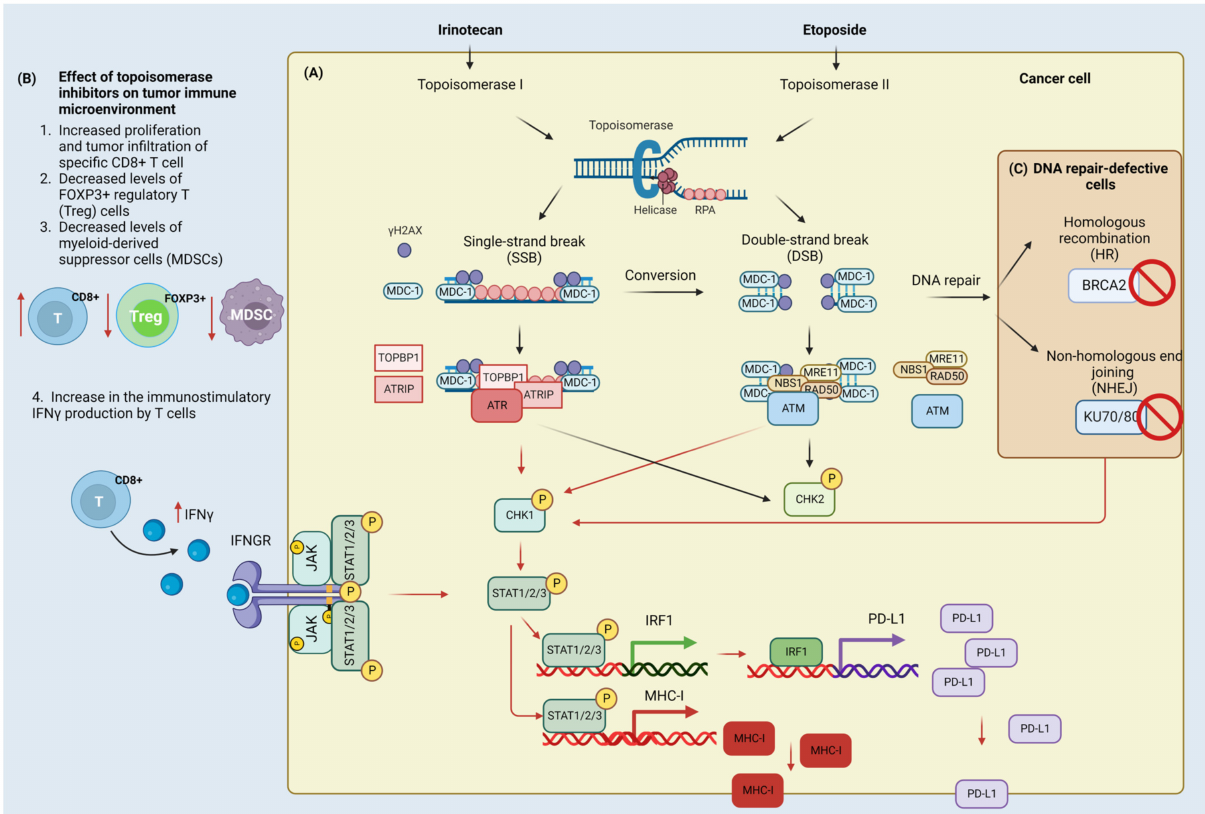
Figure 2. Effect of irinotecan and etoposide on the DNA damage (DDR) and immune response. Cancer cell ( A ) Irinotecan inhibits DNA topoisomerase I which leads to the formation of single-strand breaks (SSBs) and double-strand breaks (DSBs). Single-stranded DNA (ssDNA) in the replication fork that arises due to helicase activity is coated with replication protein A (RPA) protein and a mediator of DNA damage checkpoint protein 1 (MDC-1). MDC-1 serves as a platform protein for topoisomerase 2-binding protein 1 (TOPBP1), ATR-interacting protein (ATRIP), and serine/threonine-protein kinase (ATR). In contrast, DSBs that arise through the conversion of SSBs and activity of topoisomerase II inhibitors (here etoposide) are detected by the MRN complex composed of double-strand break repair protein MRE11 (MRE11), nibrin (NBS1), and DNA repair protein (RAD50). The MRN complex is involved in the recruitment and activation of ATM kinase. Activated ATR and ATM phosphorylate have multiple targets including checkpoint kinases (CHK1/2). The phosphorylation of H2AX and accumulation of MDC-1 contribute to further recruitment of ATR/ATM kinases and amplification of damage signaling. CHK1 activation leads to the phosphorylation of signal transducers and activator of transcription (STAT) proteins that control (up-regulate) the expression of interferon regulatory factor (IRF1) and the major histocompatibility complex class I molecule (MHC-I).